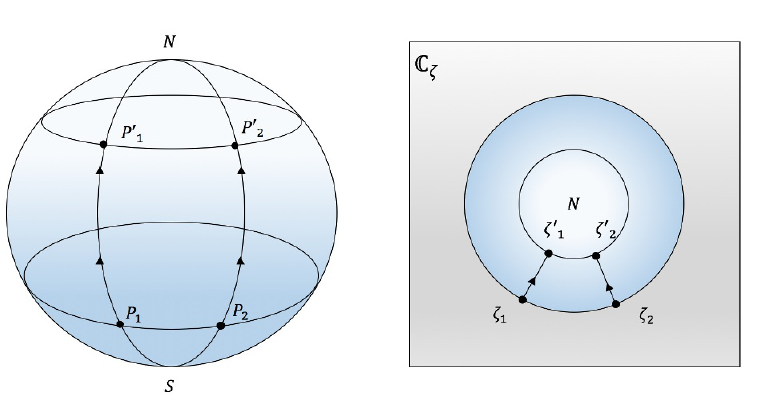
Figure 4 . The action of a boost along the x 3 direction on points on the celestial sphere, and the corresponding action on C (cid:16) . The two radii are such that j (cid:16) 0